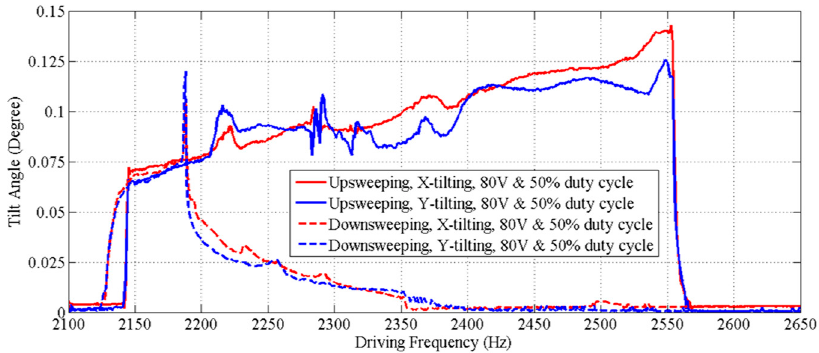
Figure 9. Frequency response curves for tilt angles over the frequency response range of the out-of-plane translational motion. These curves are similar to those for translation, and have the same response frequency range.